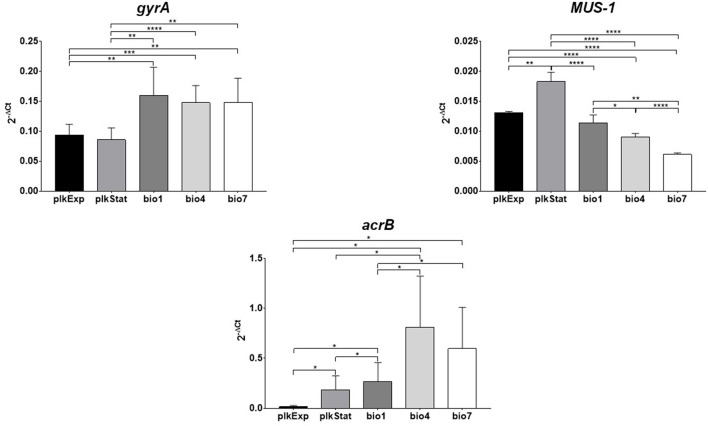
Assessment of gyrA, MUS-1, and acrB expression during planktonic and biofilm growth phenotypes of Myroides odoratimimus. RNA was isolated from both planktonic (plkExp: during exponential growth phase; plkStat: during stationary growth phase) and biofilm cells grown for 1 (bio1), 4 (bio4), and 7 (bio7) days in collagen gel matrix (37°C, pH 7.2, glucose 12.5 mM). The relative expression of each gene was then measured by RT-PCR and normalized to that of the housekeeping gene, according to the 2−ΔCT method. Results are shown as mean + SD (n = 6). *p < 0.05, **p < 0.01, ***p < 0.001, and ****p < 0.0001, unpaired-t test.